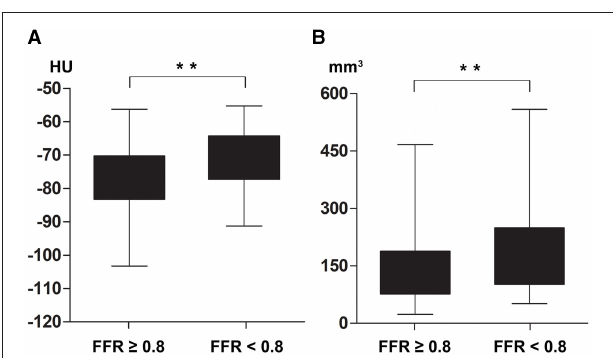
FIGURE 3 | Comparisons of lesion-specified fat attenuation index (FAI lesion ) and total plaque volume (TPV) in vessels with or without functional ischemia. Lesions with functional ischemia had higher FAI lesion , − 71 ± 8 HU vs. − 76 ± 9 HU, p < 0.01 (A) ; and greater TPV, 157 (102, 248) mm 3 vs. 126 (77, 188) mm 3 , p < 0.01 (B) . FAI lesion , lesion-specific fat attenuation index; TPV, total plaque volume; FFR, fractional flow reserve; HU, Hounsfield unit. ** p < 0.01.